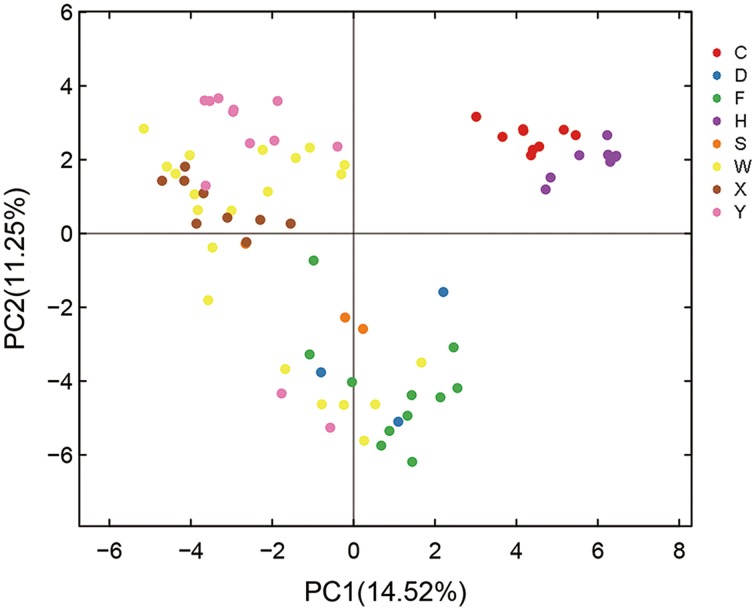
Principal component analysis (PCA) of variations in citrus AMF community from different habitats. C means samples collected in Chengdu city; D, Danjiangkou city; F, Xinfeng town; H, Hanzhong city; S, Shaoyang city; W, Wuhan Huazhong Agricultural University; X, Xunwu town; Y, Yiling city.